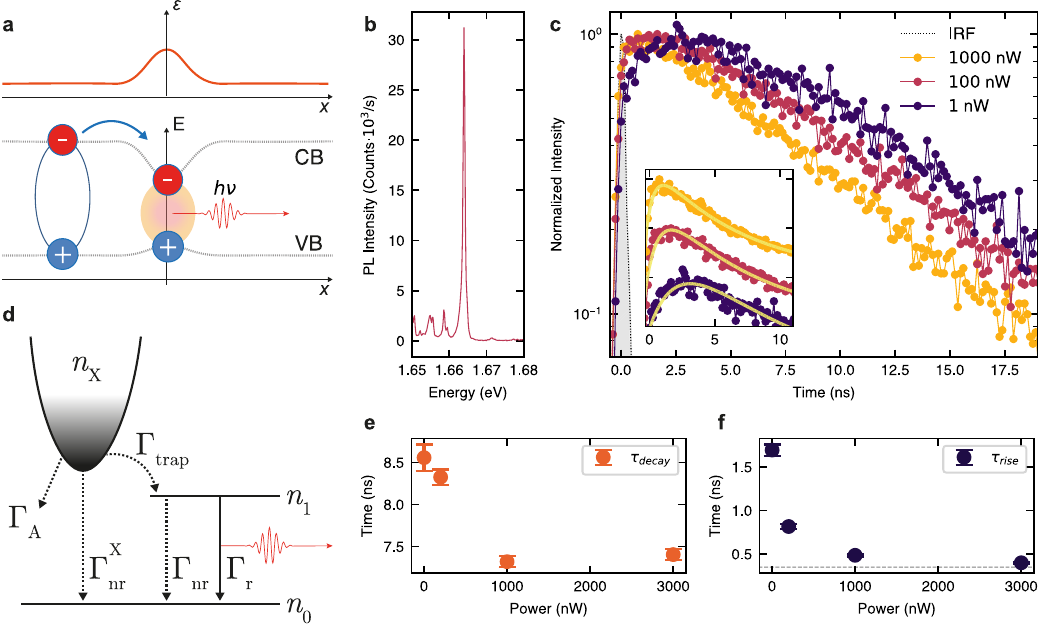
Fig. 3 PL dynamics in SPEs coupled to GaP nanoantennas. a Schematic showing the conduction (CB) and valence band (VB) behavior as a function of strain (shown in the top panel with a red line), and a single exciton trapping from the reservoir in 2D WSe 2 into a strain-induced potential minimum, giving rise to the nonclassical light red-shifted from the emission in the unstrained monolayer. b Time-integrated PL spectrum of the strain-induced WSe 2 SPE with a QE of 86% and saturation power of 57 nW for 80 MHz repetition rate, for which the data in ( c ), ( e ), and ( f ) are presented. c PL decay curves for the SPE in ( b ) measured at different laser powers. The instrument response function (IRF) is shown in gray. Inset: zoom-in of the PL traces also showing fi tting with the analytical model discussed in Supplementary Note VII. The PL traces in the inset are plotted on a linear scale and shifted vertically for display purposes. d Schematic of the three-level system representing the dark exciton reservoir ( n X ), the exciton in the SPE ( n 1 ) and the ground level ( n 0 ), and the processes describing radiative and nonradiative decay of n X and n 1 populations. See text for more details. e , f PL decay ( e ) and PL rise ( f ) times, as a function of the excitation power, obtained from the data fi tting in Fig. 3c. For 3000 nW, τ rise approaches the instrument resolution (gray dashed line). The error bars are calculated from the standard deviation of the fi t